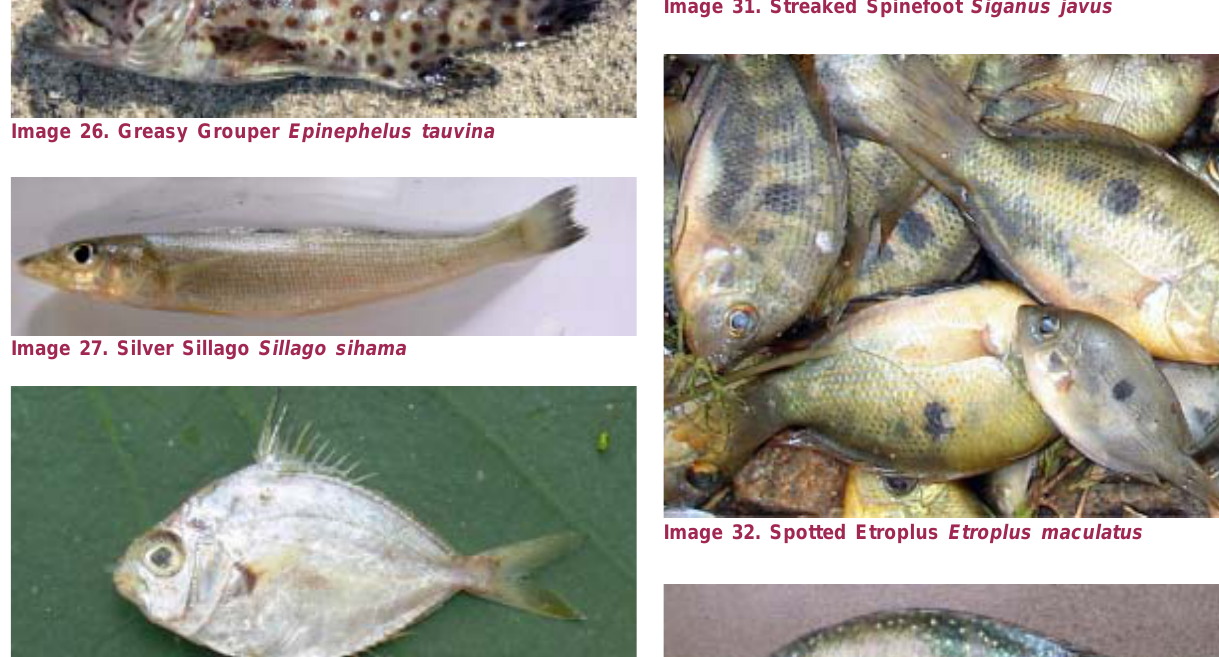
Image 31. Streaked Spinefoot Siganus javus